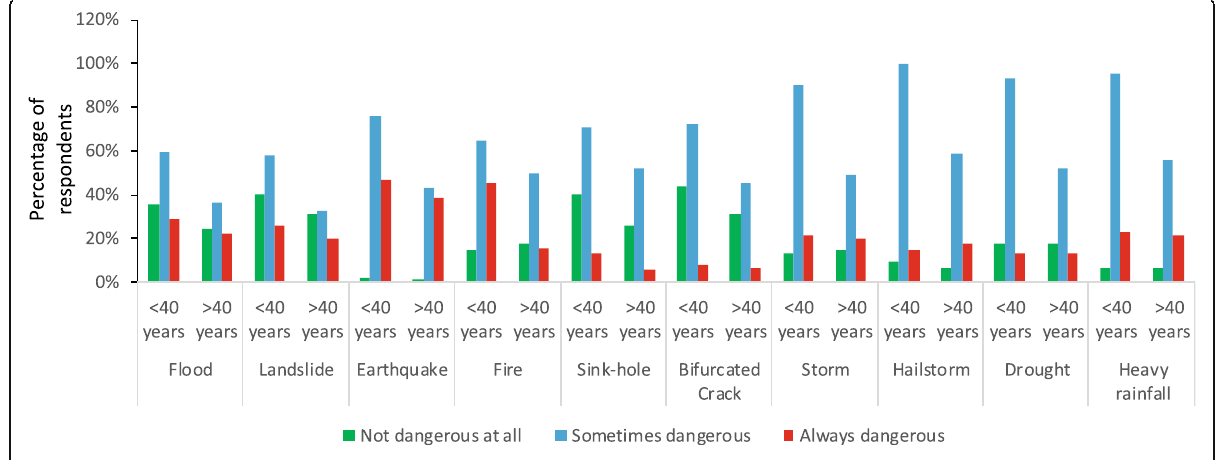
Fig. 8 Age based response for various kind of disaster and associated level of